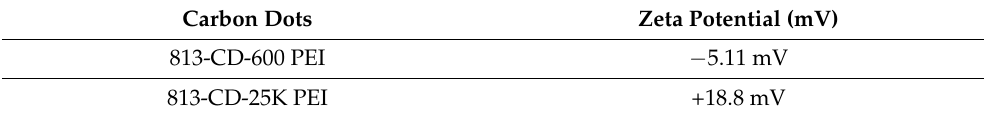
Table 2. Zeta potential of respective